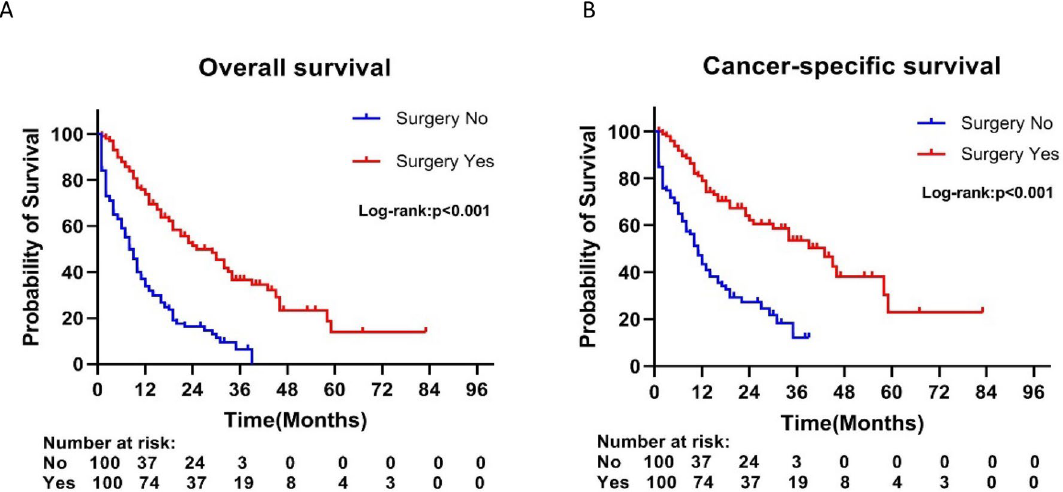
Figure 3. Kaplan–Meier curves of ( A ) overall and ( B ) cancer-specific survival according to whether patients underwent primary tumor surgery in the overall cohort after propensity score matching.